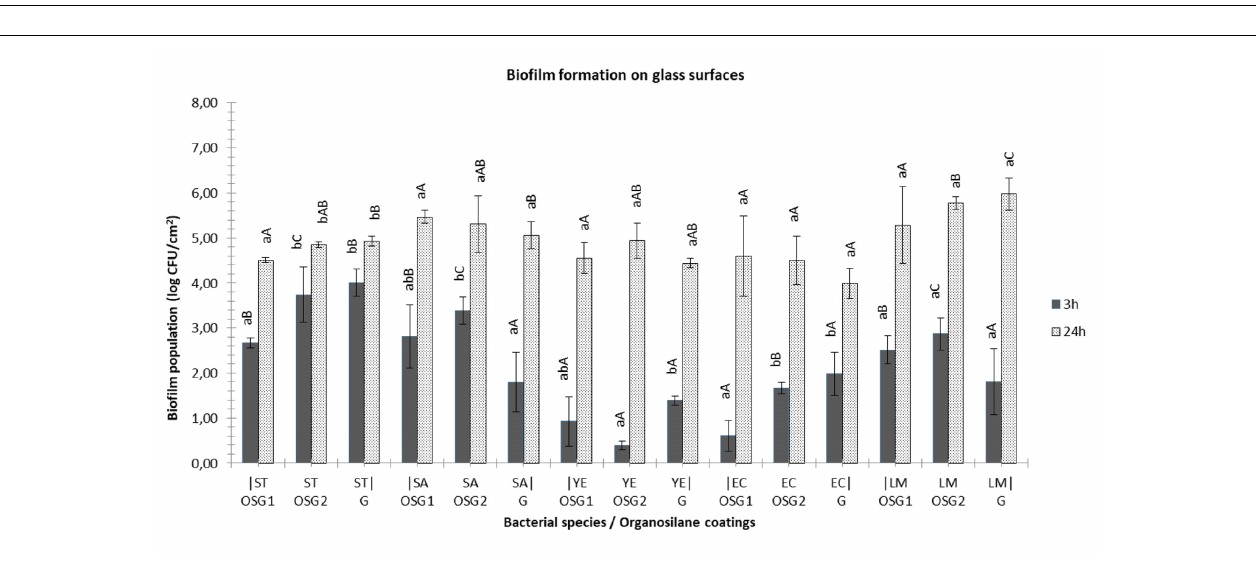
FIGURE 1 | Biofilm formation on polystyrene microtiter plates of different strains after 24 and 48 h of incubation at 37 ◦ C. Biofilm cells were indirectly quantified by crystal violet staining and absorbance measurements at 575 nm. Bars represent means ± standard deviations. Different letters at 24 or 48 h indicate significant differences between biofilm formation of strains ( P < 0.05).